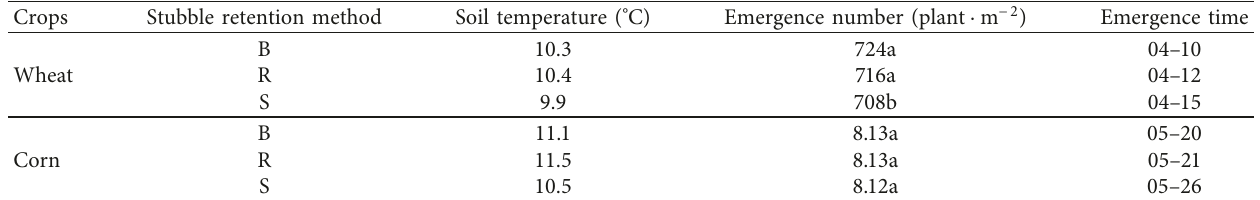
Table 2: Effects of stubble retention methods on emergence number, emergence period, and soil temperature of intercropping wheat and maize.